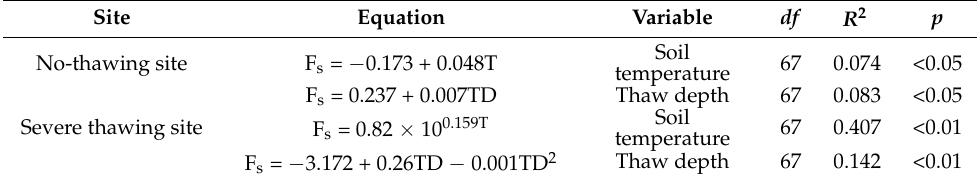
Table 2. Correlations between CH 4 flux and environmental factors.